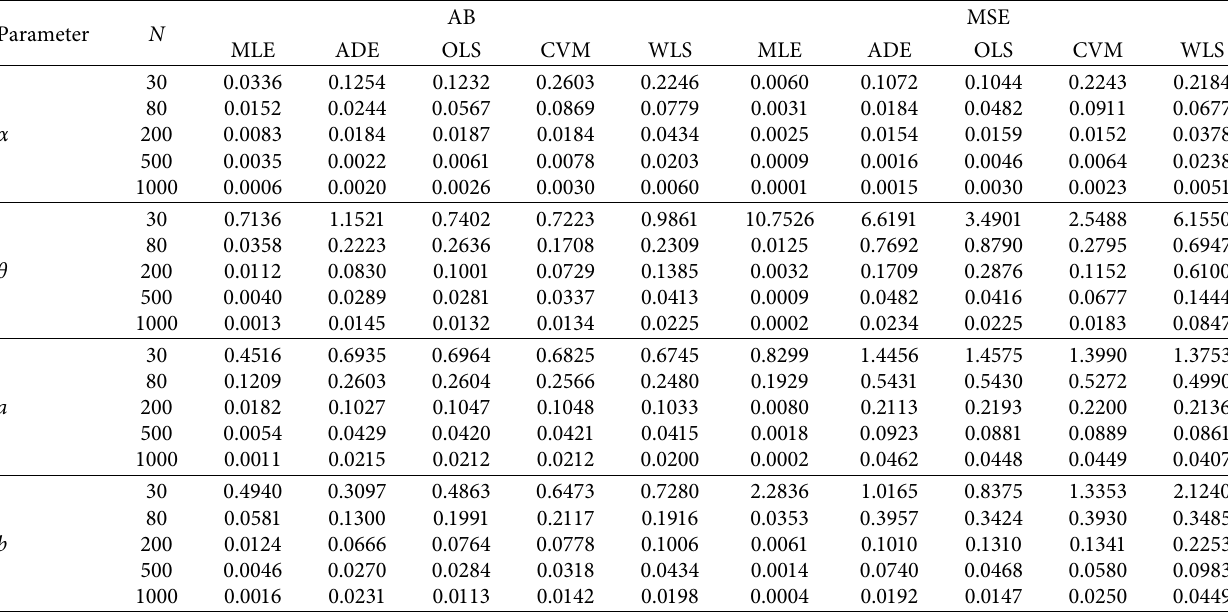
Table 5: Results of simulations for ( α , θ ,a, b ) � ( 0 . 03 , 0 . 42 , 2 . 2 , 2 . 6 ) .